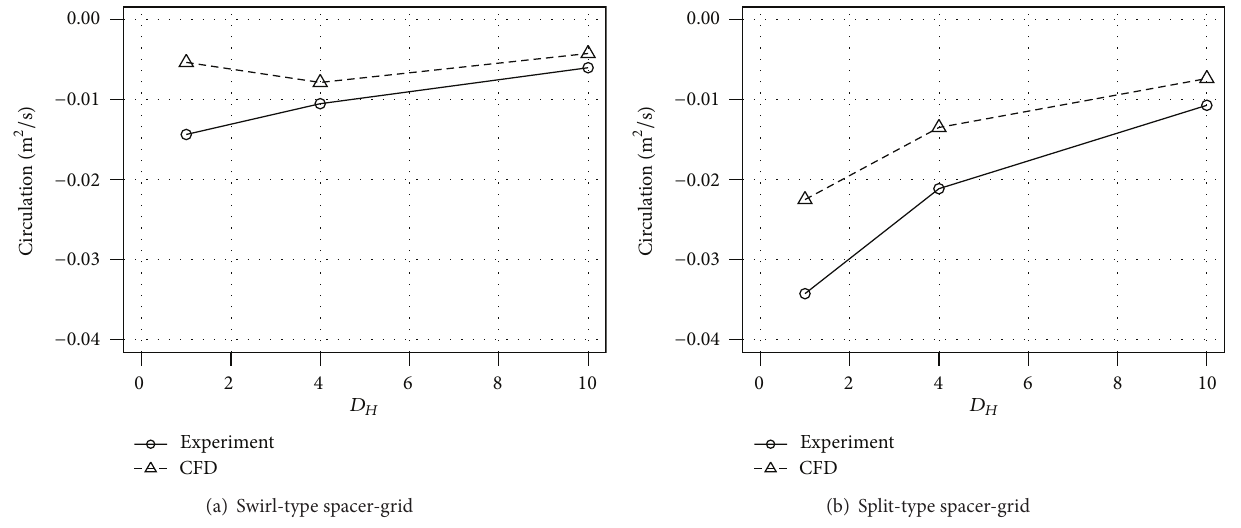
Figure 17: Evolution of the circulation along the streamwise